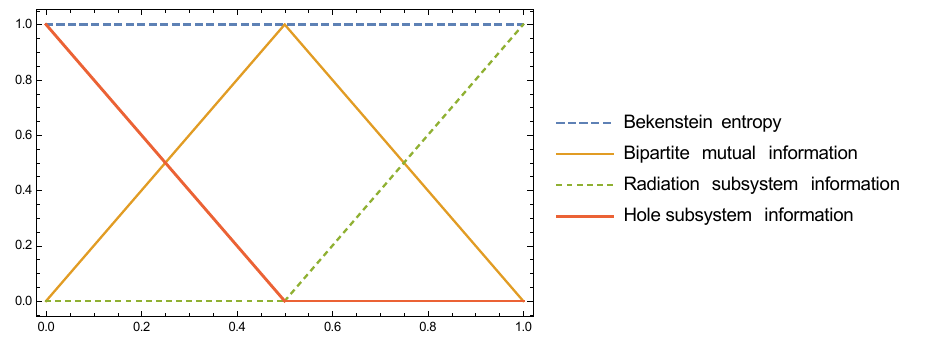
Figure 3. Modified Page curves for the bipartite mutual information and the asymmetric subsystem information: These are derived under the “average subsystem” assumption applied to a pure-state bipartite system consisting only of (black hole) plus the (Hawking